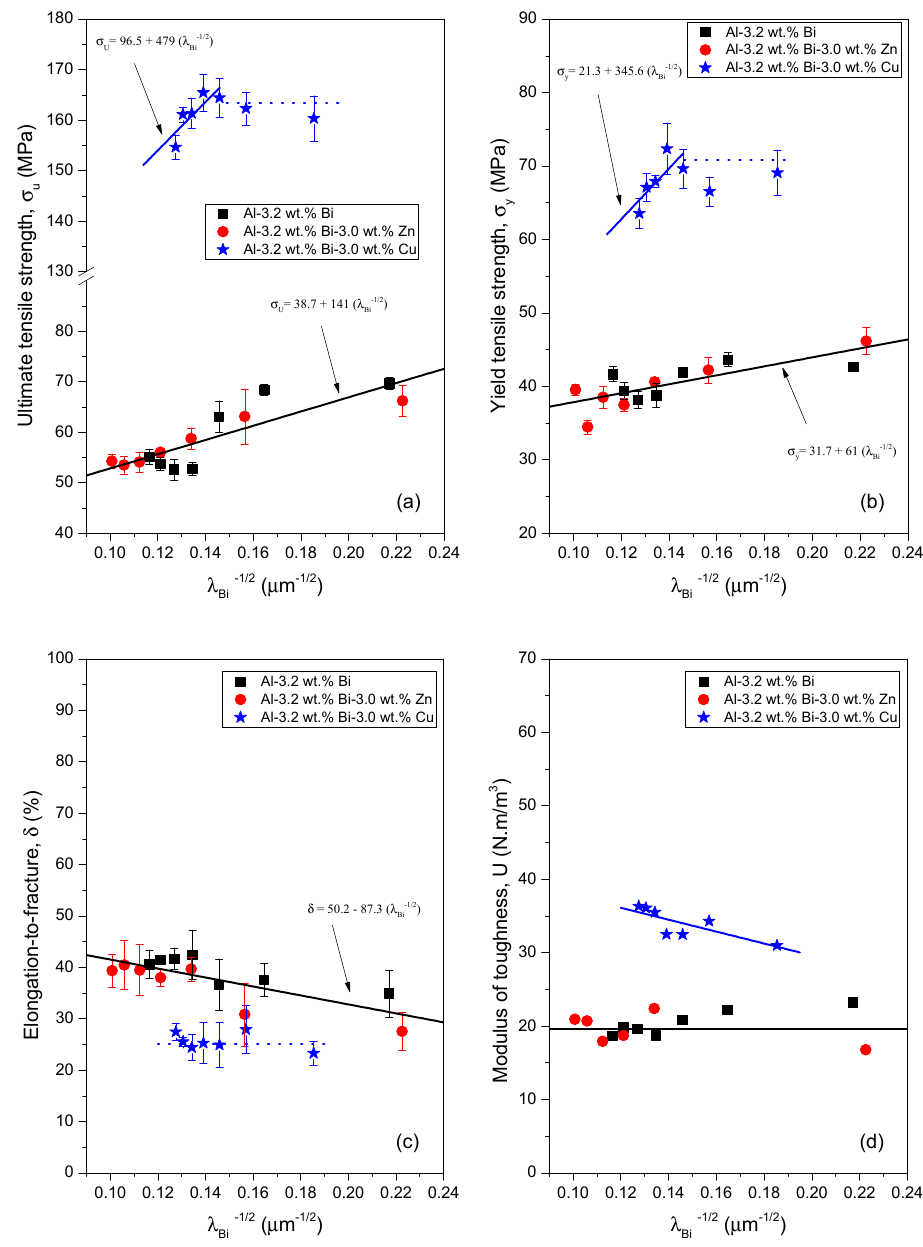
Figure 9. Tensile properties of the DS Al-Bi(-Cu,-Zn) alloys: ( a ) σ u vs. λ Bi − 1/2 , ( b ) σ y vs. λ Bi − 1/2 , ( c ) δ vs. λ Bi − 1/2 , and ( d ) U vs. λ Bi − 1/2 .